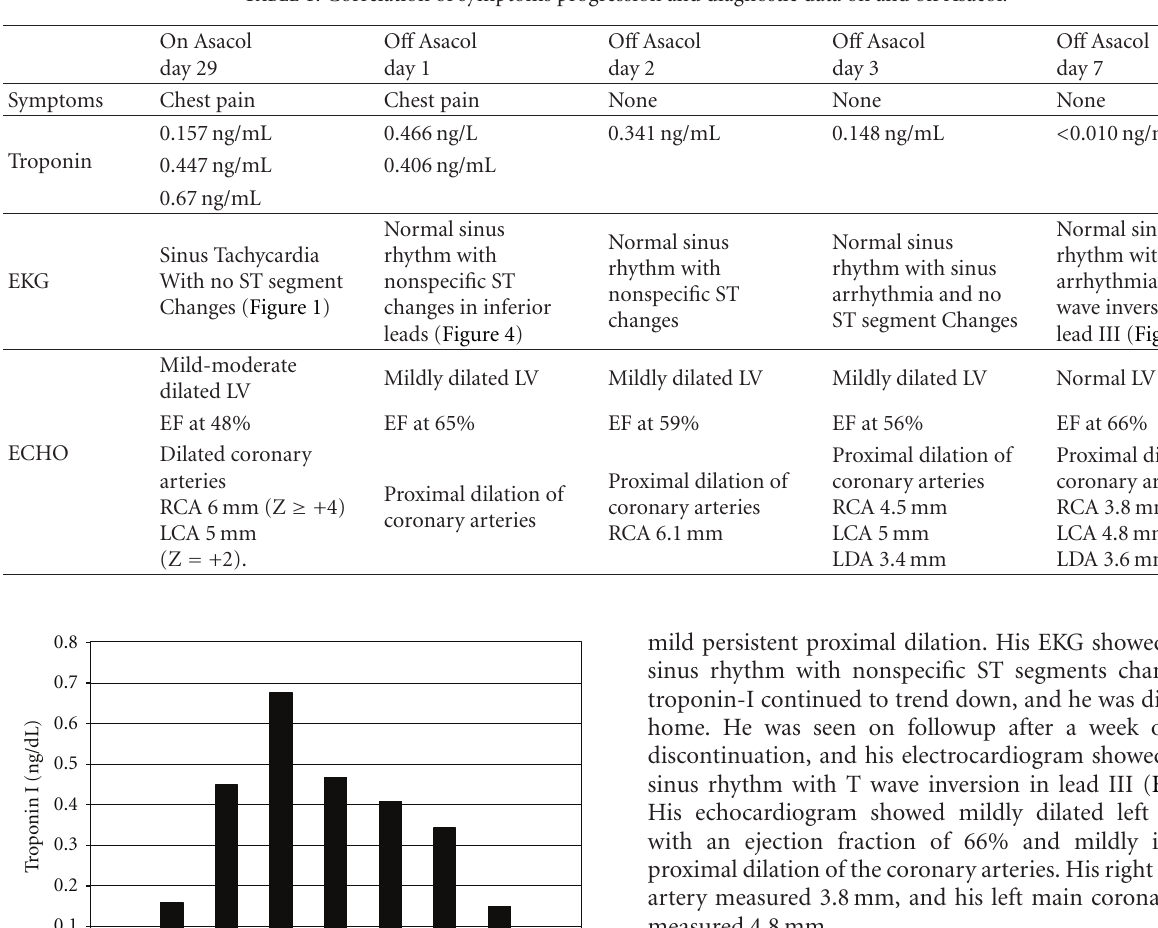
Table 1: Correlation of symptoms progression and diagnostic data on and o ff Asacol.